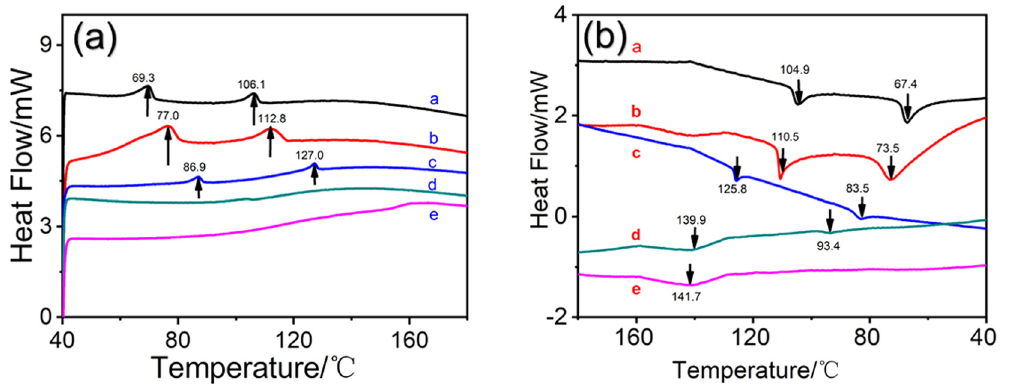
Figure 3: DSC heating and cooling curves of LCP ( a ) , POSS:LCP = 1:16 ( b ) , POSS:LCP = 1:5 ( c ) , POSS:LCP = 1:1 ( d ) , and POSS ( e ) at a rate of 20 K/min.